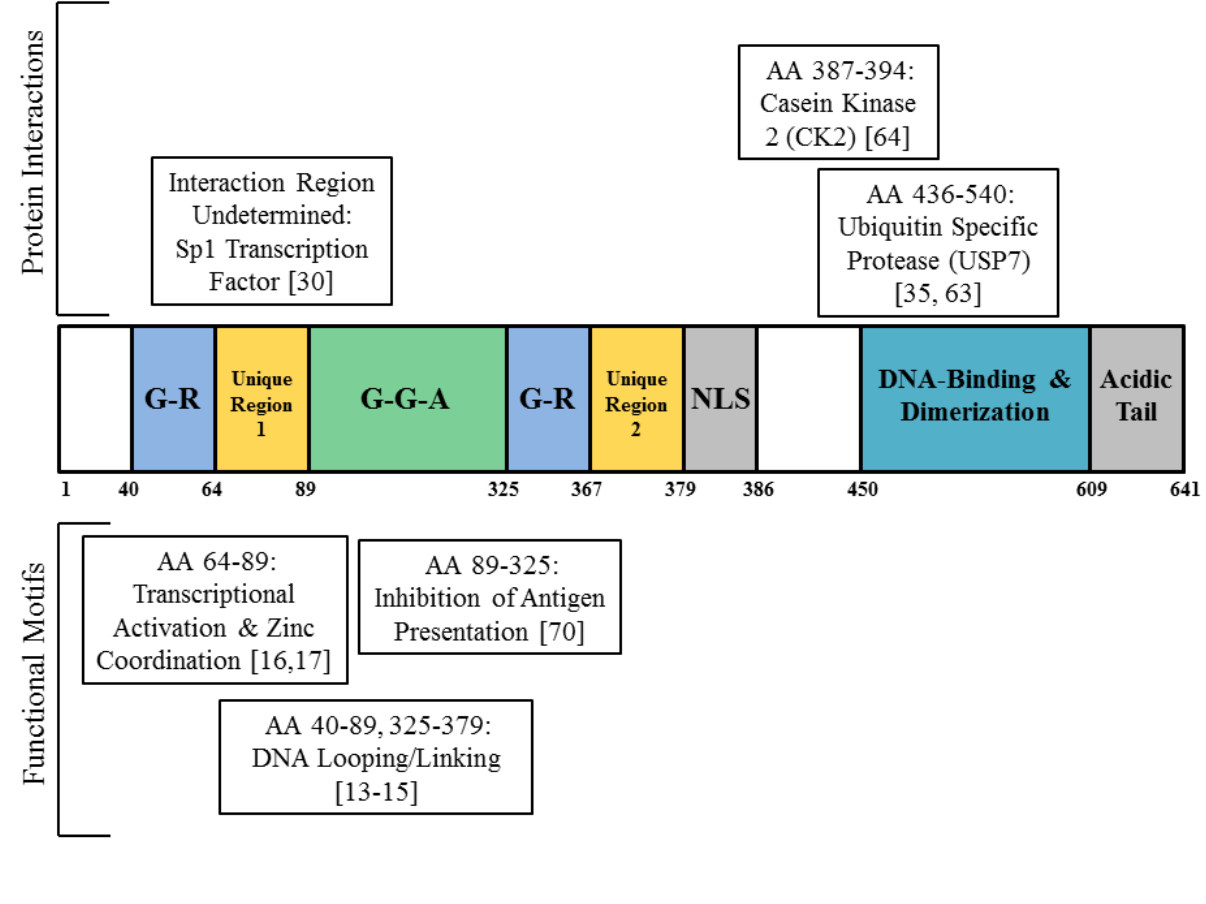
Figure 1. A Structural Representation of Epstein-Barr Nuclear Antigen 1 (EBNA1) with the Protein Interacting Domains and Functional Motifs discussed in this